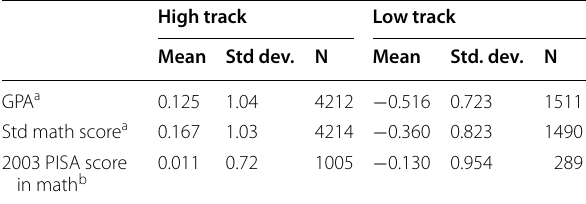
Table 4 Grade distribution by track